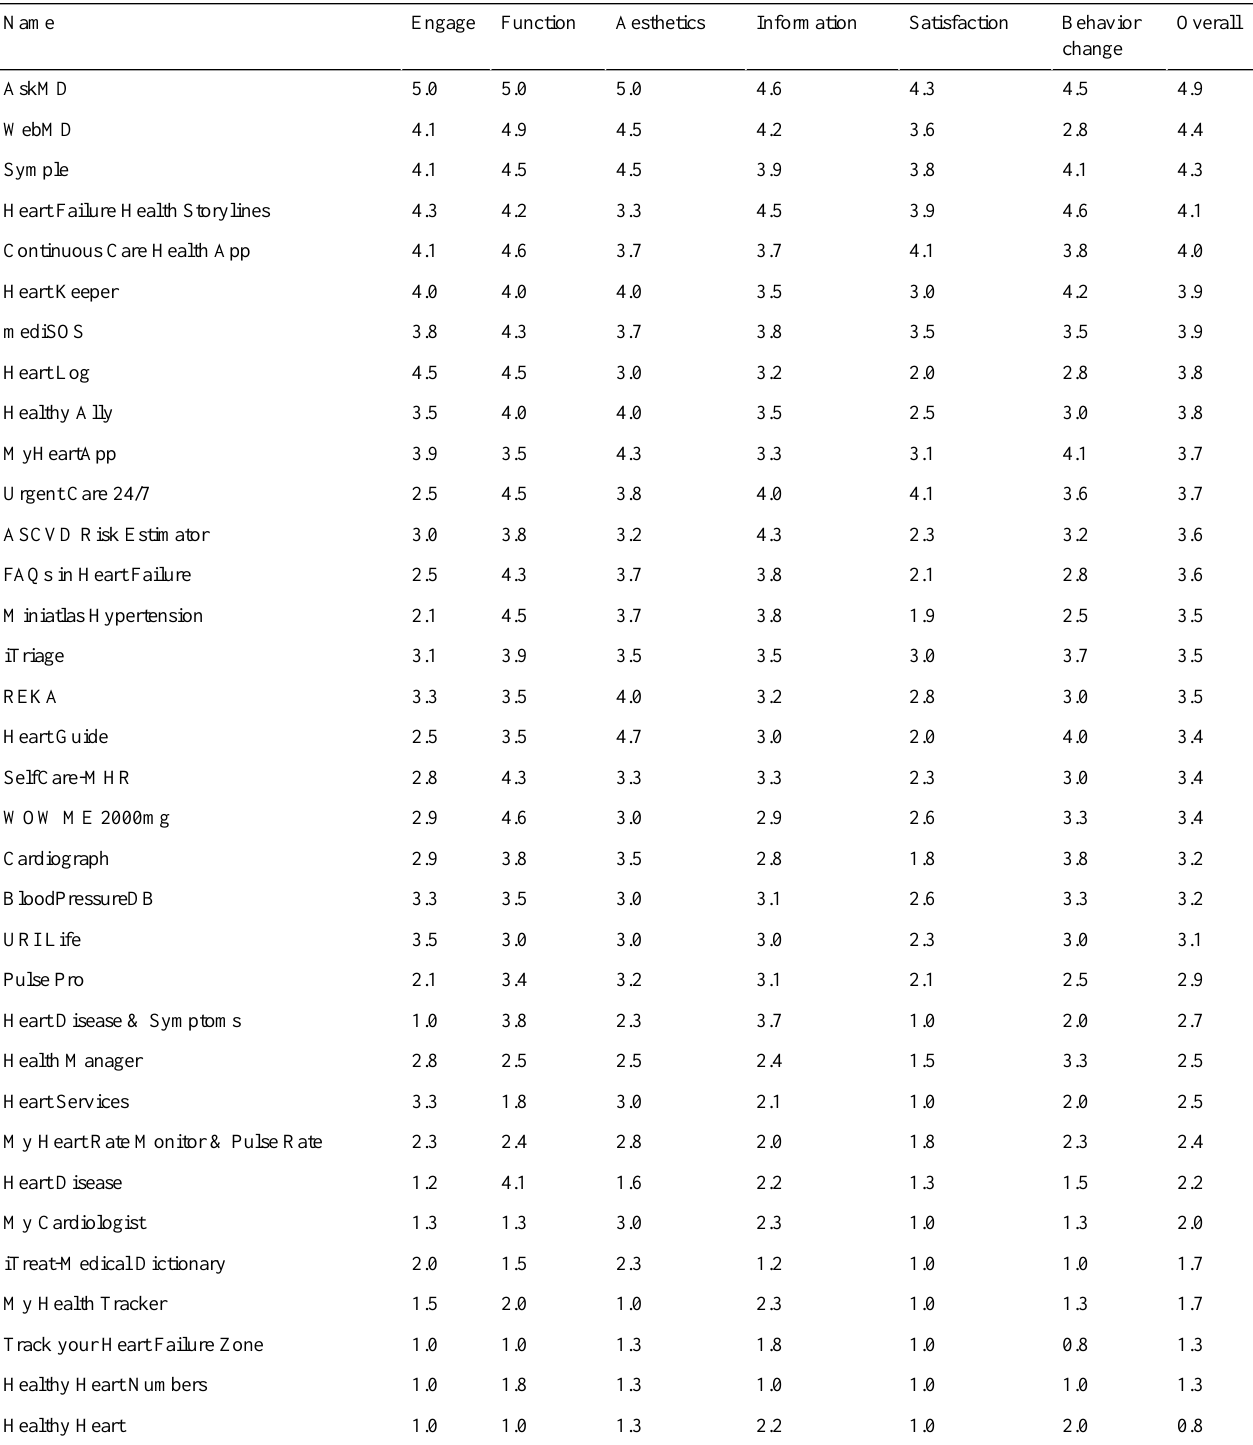
Table 3. Mobile Application Rating Scale